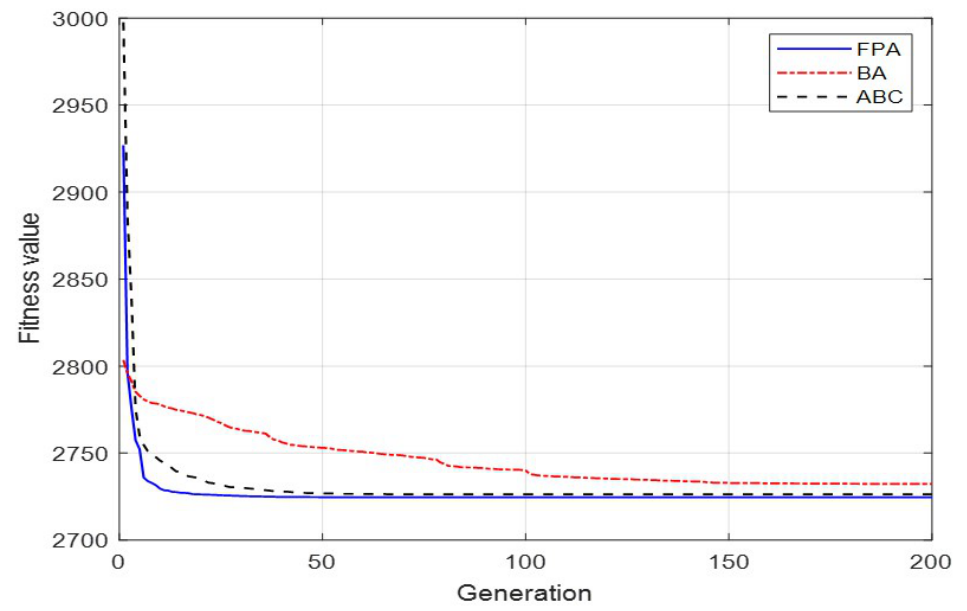
Figure 9. Convergent behaviors using the bat algorithm (BA), artificial bee colony (ABC), and FPA fuzzy control Figure 4. Scheme of the experimental procedure.